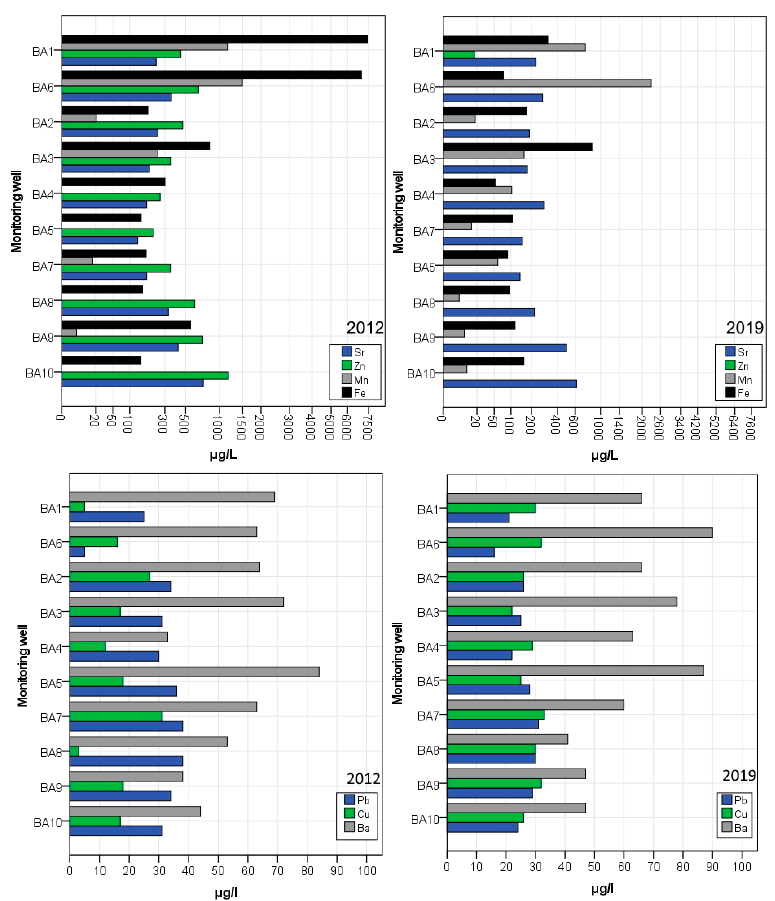
Figure 8. Groundwater microelement content changes in the monitoring wells in 2012 and 2019.